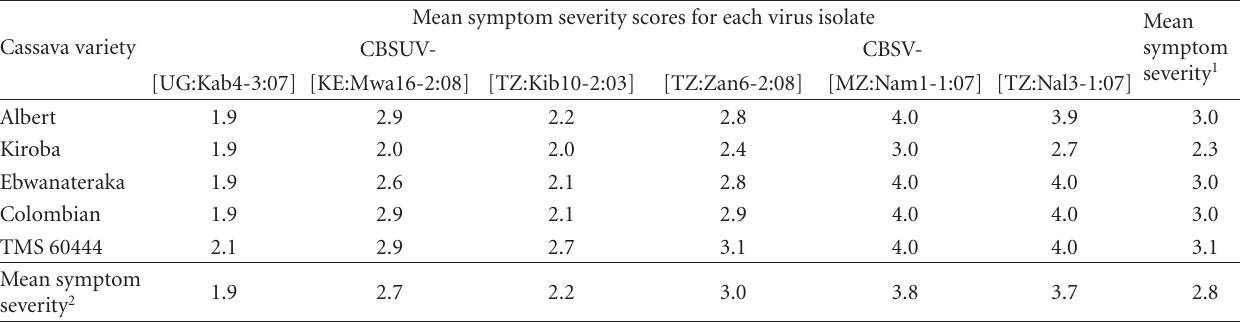
Table 5: Mean symptom severity scores for each CBSD isolate on di ff erent cassava varieties (on a 0–5 scale using the procedure of [9]). Mean symptom severity scores for each virus isolate Cassava variety